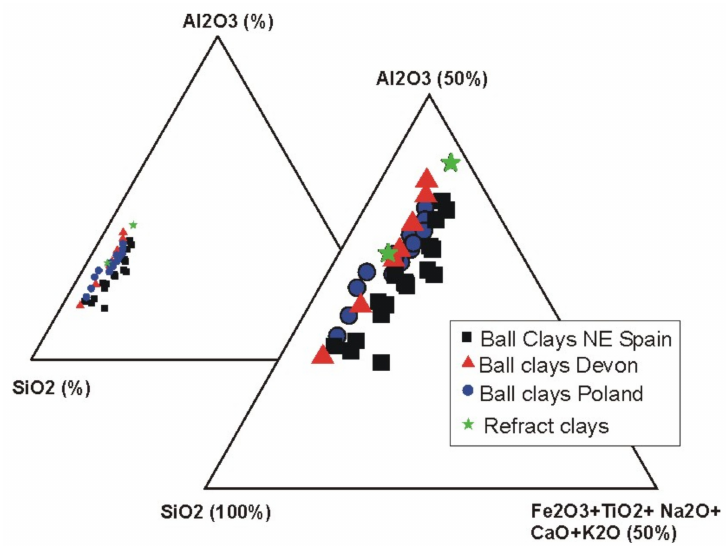
Figure 8. Plot of the chemical composition of the ball clays from NE Spain (this study), ball clays from Devon [1], ball clays from Poland [9], and refractory clays [24]. (Table